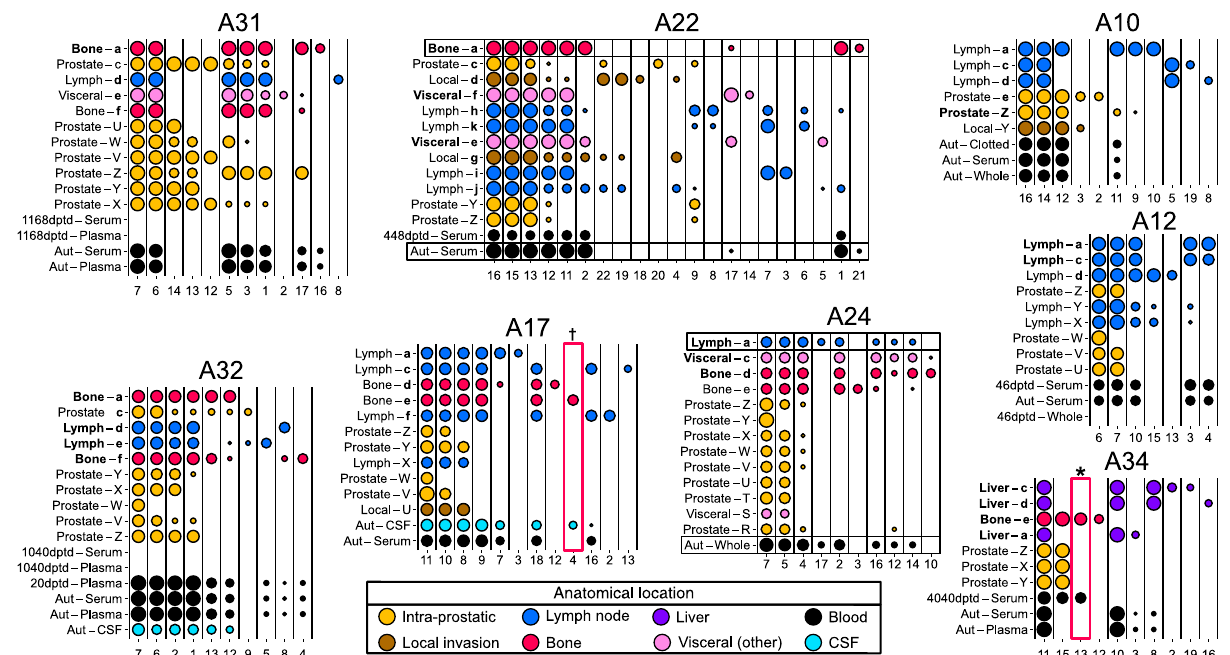
Fig. 6 Subclones in tissue samples can be identi fi ed in DNA obtained from liquid biopsy. Plots showing the proportion of single nucleotide variants corresponding to each subclone (numbered on x-axis) that are observed in each sample (letters on y-axis). The area of the circle is proportional to the cancer cell fraction (CCF) of the subclone, with CCF of 1 found in the leftmost (truncal) nodes of the subplot. Anatomical location of tissue samples are also given in the sample label, and colored as in the legend. Body fl uid samples are denoted by the time when the sample was taken (Aut = autopsy, dptd = the number of days prior to death), and the type of fl uid (Serum; Plasma; blood, either Clotted or Whole; Cerebrospinal fl uid (CSF)). Sample locations in bold are those that contain lineages represented in liquid biopsy at the highest CCF. Tissue samples in black boxes were polyclonal mixtures and contained similar subclonal CCFs to the boxed body fl uid sample. Red boxes denote subclones of interest: star denotes subclones corresponding to a lineage found only in a spinal metastasis and serum, both of which were extracted 4040dptd, and dagger denotes a subclone that is only observed in a subdural metastasis and